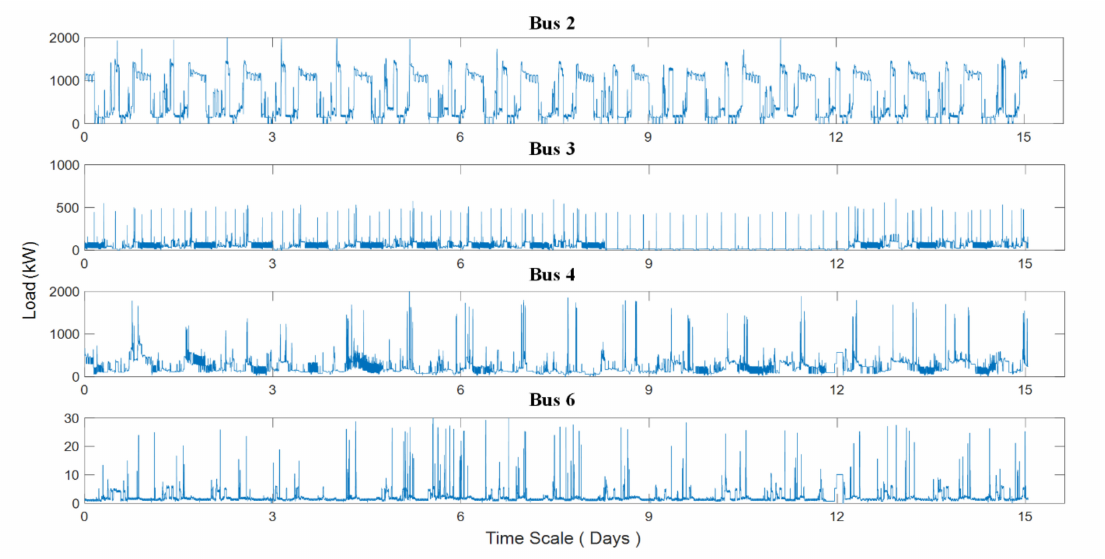
Figure 8. Three-phase load profile for bus 2, 3, 4 and